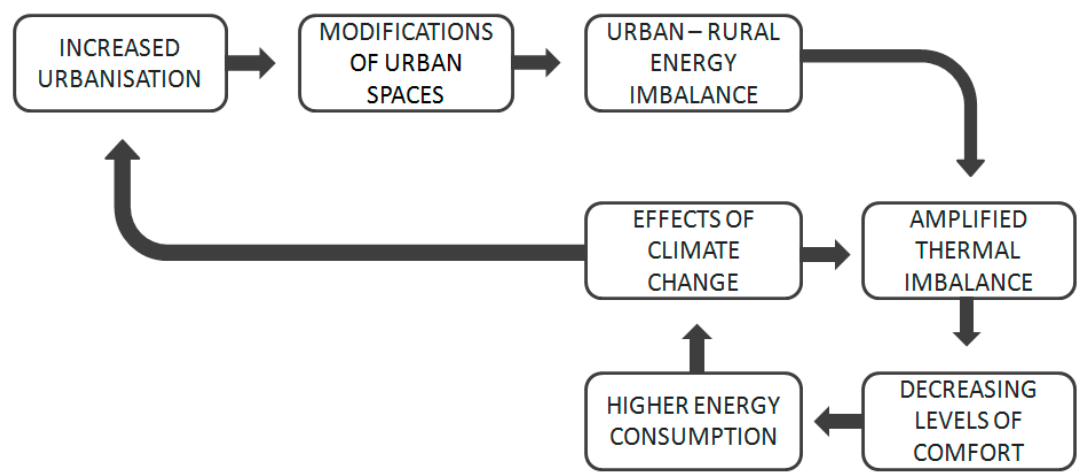
Figure 1. Causality of Urban Heat Islands (UHIs) development (based on works published by [1,3]). UHIs as defined by [5] and [6] are distinctive layers of the urban atmosphere related not only to the di ff erent surfaces but also sub-surfaces and can be established for Urban Boundary Layer